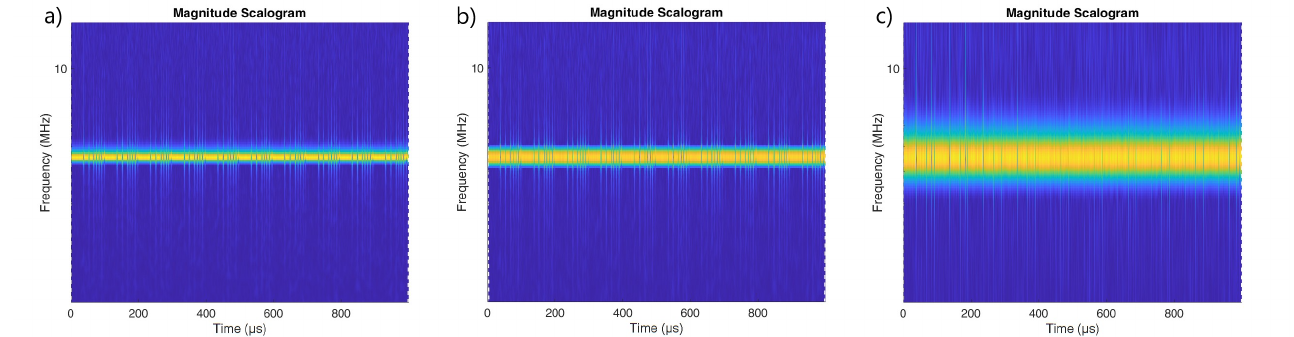
Figure 2. Scalogram for the LFMCW signal made using wavelets: ( a ) Morse γ = 27, β = 27. ( b ) Bump ( c ) Morse (default parameters) γ = 3, β = 20.